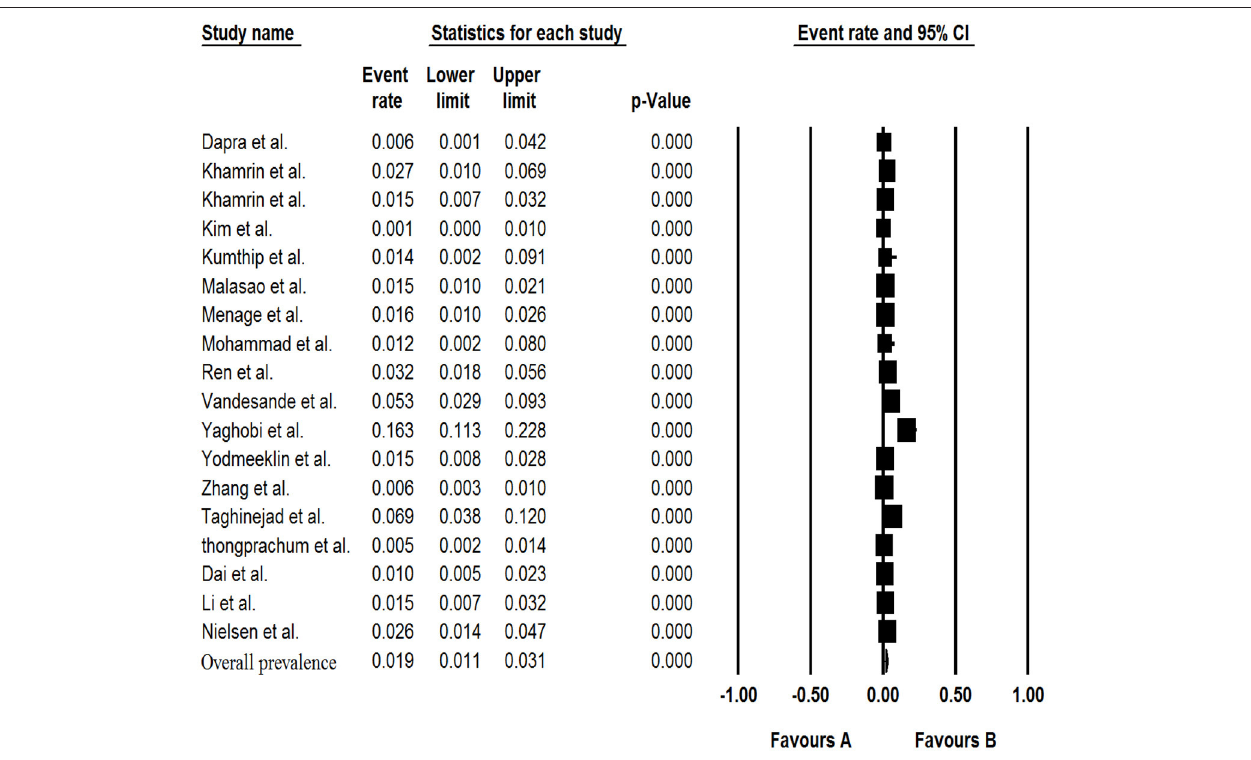
FIGURE 4 | Forest plot of the pooled prevalence for